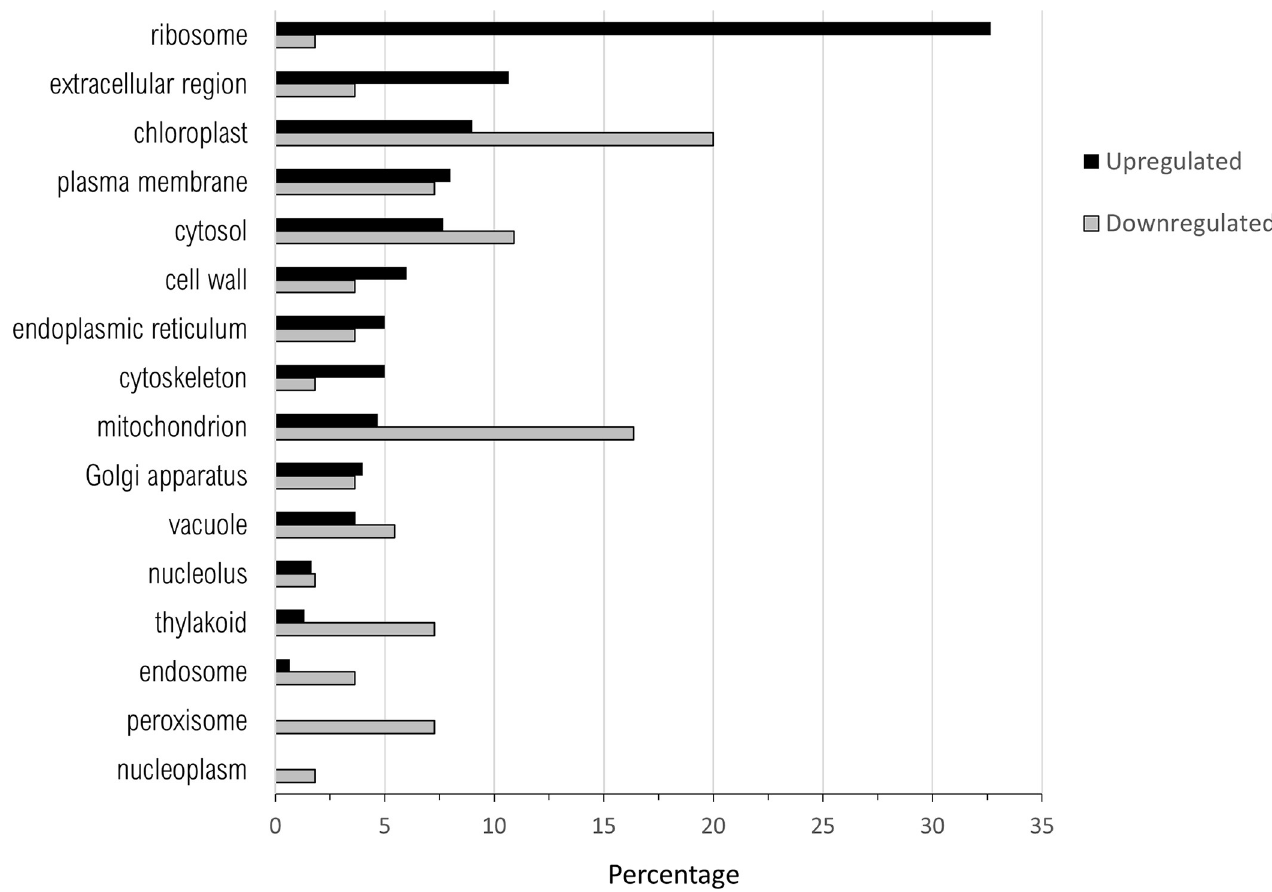
Fig 7. Percentage of upregulated (total number = 300) and downregulated (total number = 55) when nickel resistant Populus tremuloides genotypes were compared to nickel susceptible genotypes. Transcripts were assigned gene ontology and grouped by Cellular Component using BLAST2GO (Omics Box).